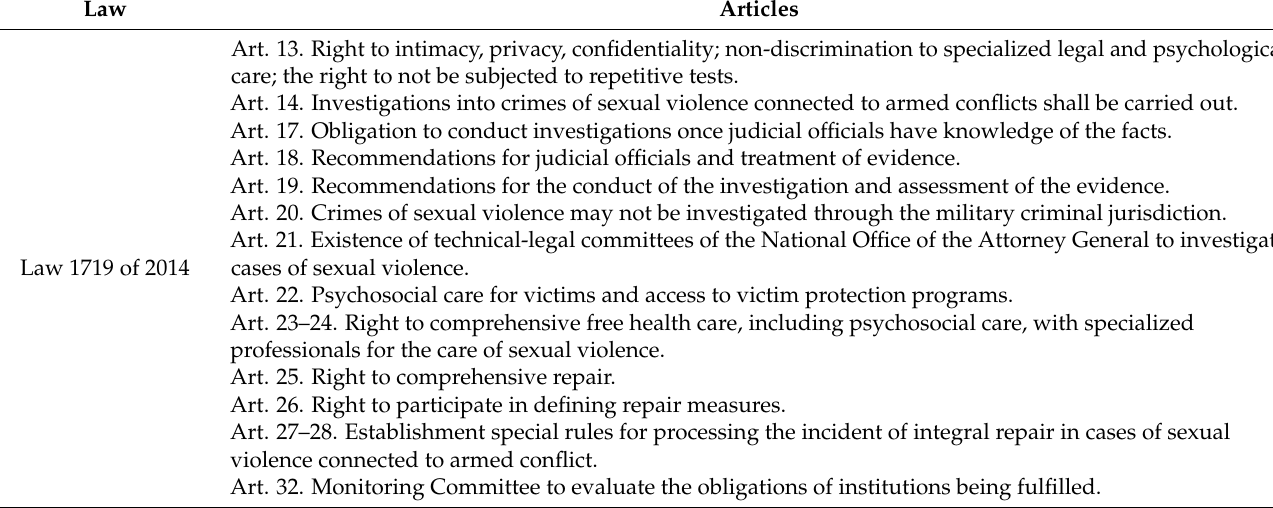
Table 3. Procedural Rights and Guarantees of Law 1719 of 2014. Law